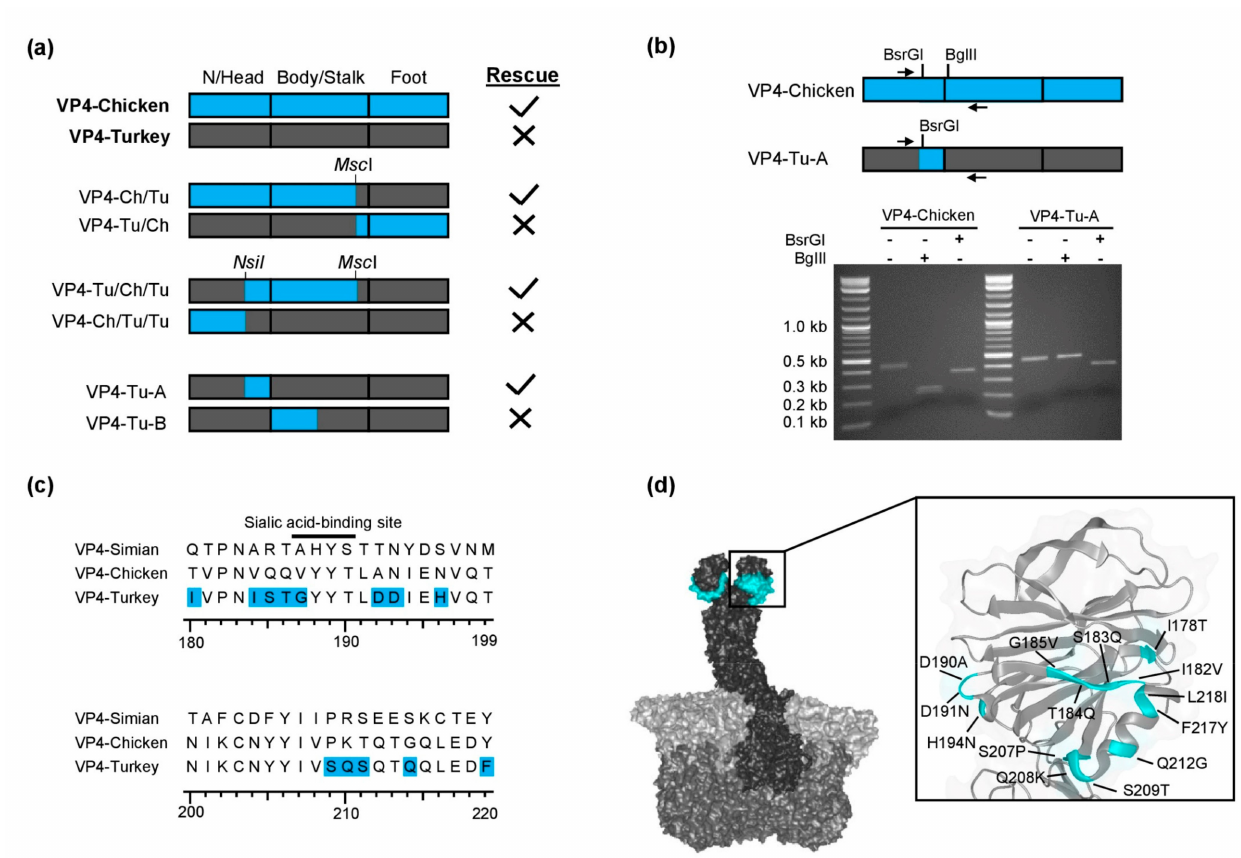
Figure 2. Chimeric chicken/turkey VP4. ( a ) Chimeric VP4-encoding genome segments used for rescue experiments. N/Head: N-terminus and head region, VP4-Chicken: blue, VP4-Turkey: dark gray. ( b ) Agarose gel analysis of a restriction enzyme digestion of RT-PCR products from VP4-Chicken and VP4-Tu-A. The primer-binding sites and restriction enzyme sites are indicated. ( c ) Amino acid sequence alignment of the C-terminal part of the VP4 head region. The amino acid residues in VP4-Tu-A that were substituted with the corresponding residues of VP4-Chicken are highlighted in blue. The black line indicates the position of a known sialic acid-binding site for simian RRV [38]. ( d ) Location of amino acid substitutions (highlighted in cyan) present in the head region of VP4-Tu-A as projected into the 3D structure of simian RRV VP4 (PDB